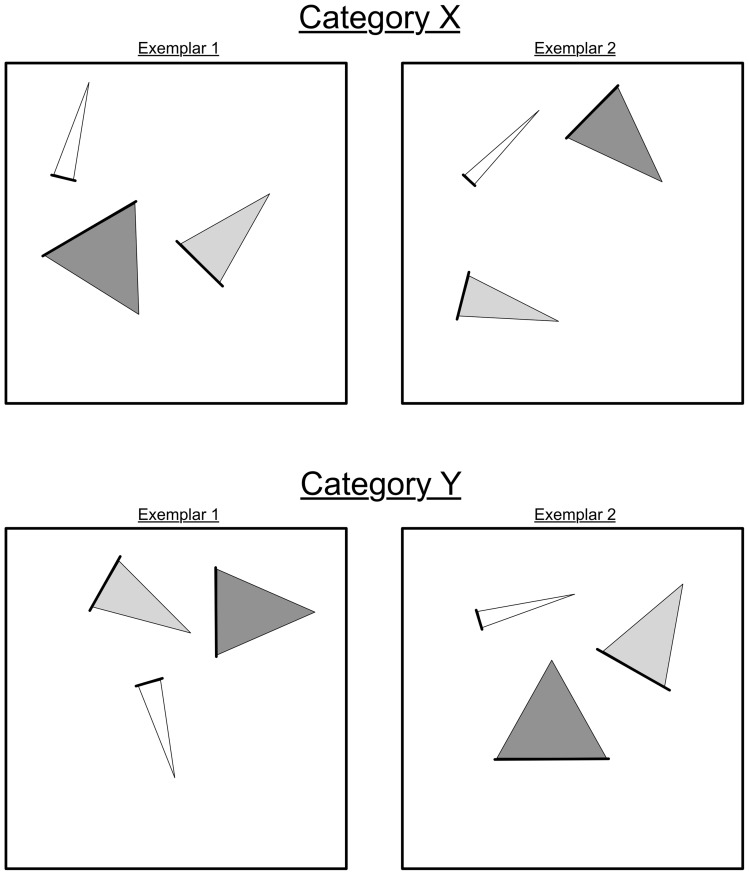
Examples of the stimuli used in Experiment 2.The top row contains two exemplars from Category X; the bottom row contains two exemplars from Category Y. Each exemplar consists of three triangles in a square-frame. Triangles differ in their location in the square-frame, their color, the width of their base (marked by the bold line), and their orientation from 0-degrees. In exemplars from Category X, triangles with thicker bases are more misoriented from 0-degrees. In exemplars from Category Y, triangles with thicker bases are less misoriented from 0-degrees.